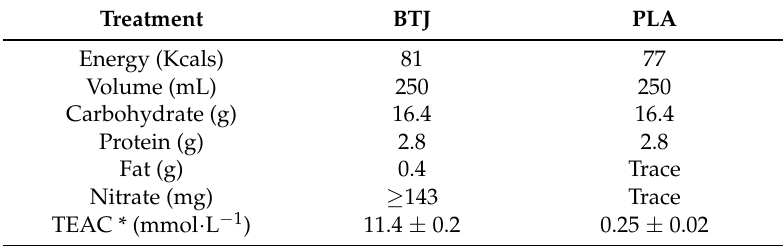
Table 2. Energy and macronutrient content, trolox equivalence antioxidant capacity (TEAC) and nitrate content of the beetroot juice (BTJ) and placebo (PLA)